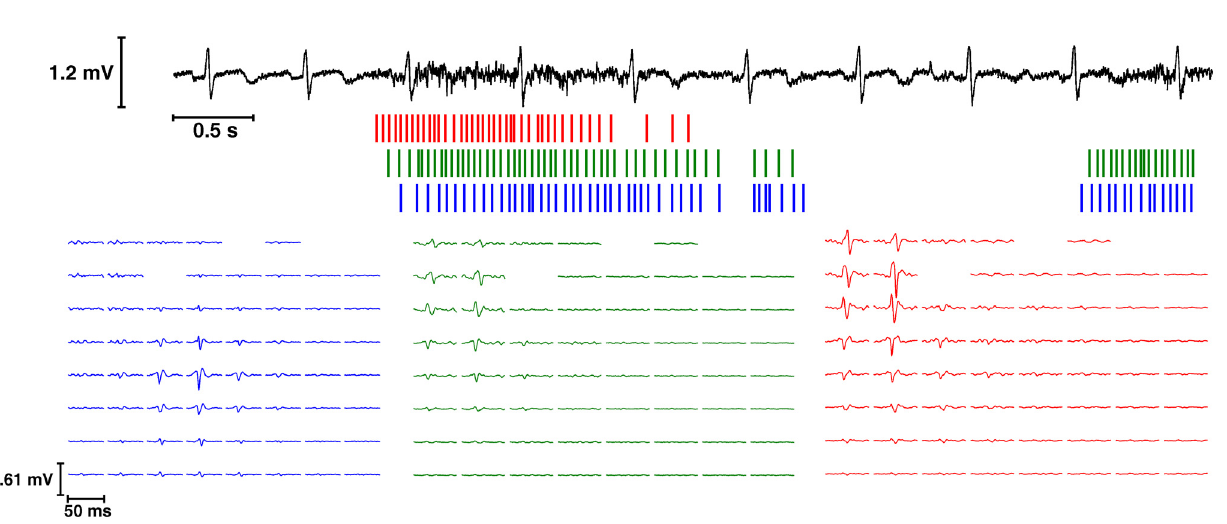
Fig 4. Representation of the decomposition of a single trial for subject T2. Above: one channel of the EMG signal. Below: bar plots of the decomposed spike trains and their MUAPs over the matrix. The colors of the spike trains and the MUAPs are matched. S1 Fig is a black and white version of this